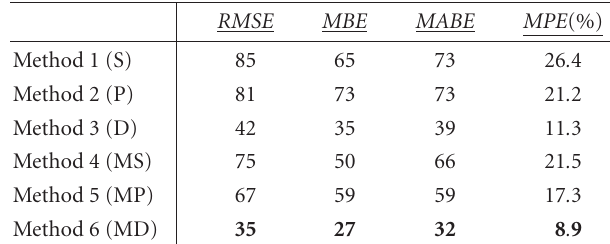
Table 3: Errors obtained from 6 methods for northern city, Ramsar m (cid:3) 2 month (cid:3) 1 except MPE which is in percent). (Units are in Mj (cid:2) (cid:2)